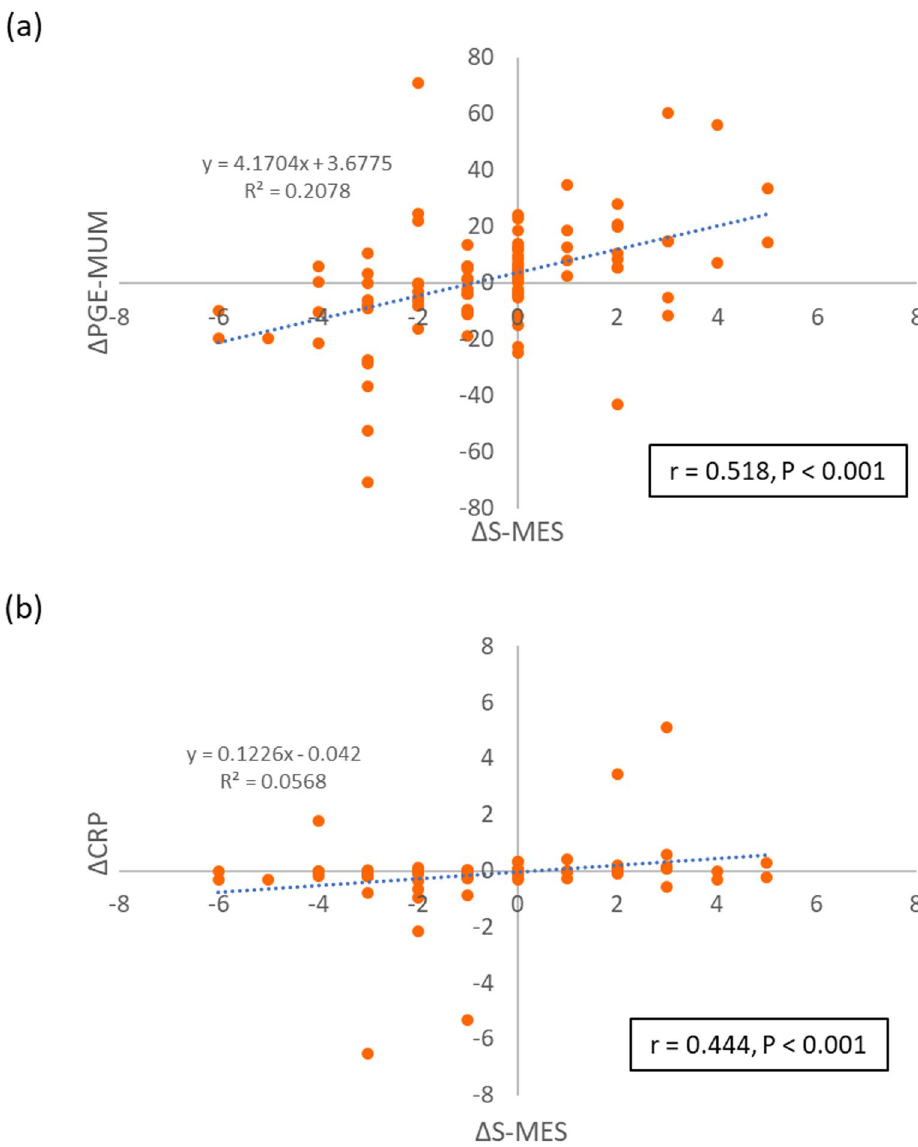
Figure 4. Correlations between variations in the sum of the Mayo endoscopic subscore (ΔS-MES) with variations in prostaglandin E-major urinary metabolite (ΔPGE-MUM) and C-reactive protein (ΔCRP). ( a ) Scatter plot of ΔS-MES and ΔPGE-MUM; ΔS-MES = (2nd–1st) S-MES; ΔPGE-MUM = (2nd–1st) PGE-MUM. ( b ) Scatter plot of ΔS-MES and ΔCRP; ΔCRP = (2nd–1st)